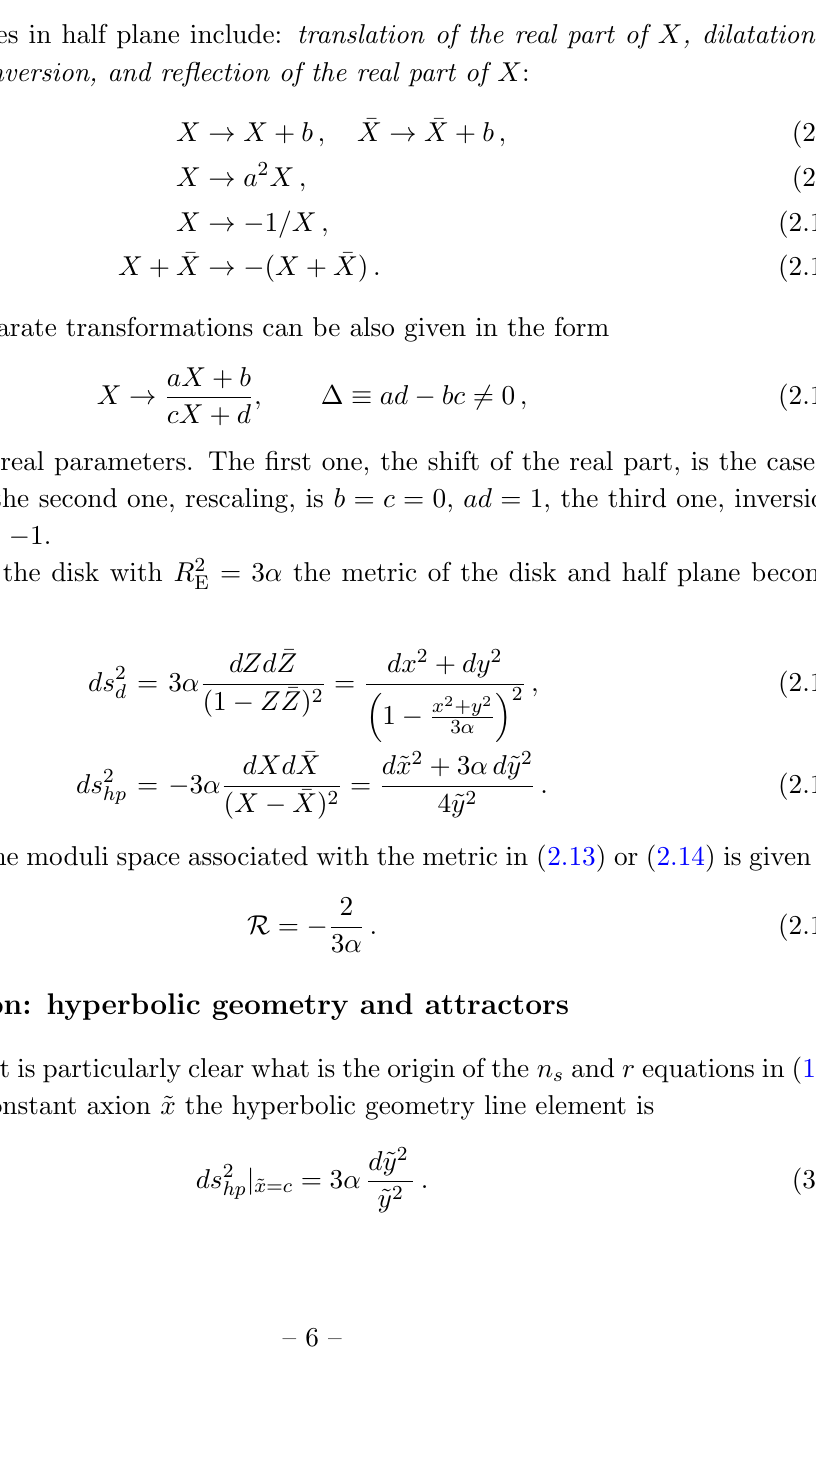
Figure 5 . Left: Escher’s tessellation of a hyperbolic half-plane with \Angels and Devils" design. Right: Cayley transform of upper complex half-plane to a hyperbolic